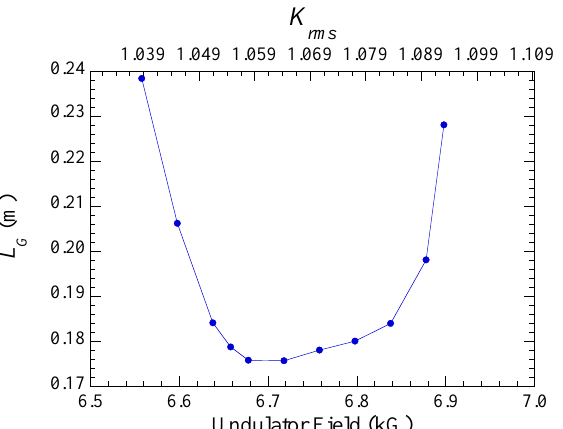
Figure 10. Gain length L G versus on-axis undulator field amplitude B u for the IR RAFEL. Other parameters as in Table